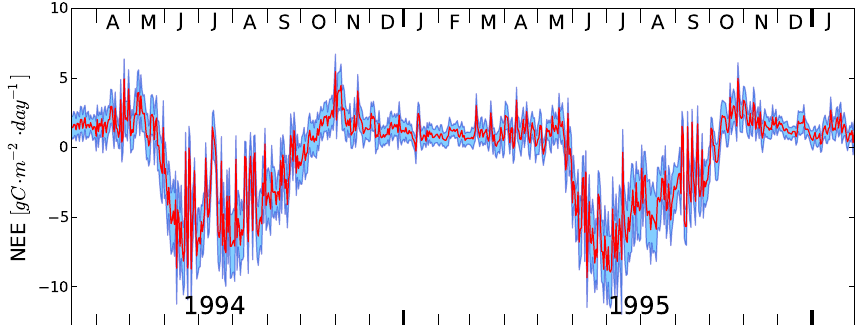
Figure 10. Snapshot of NEE observations (with red line) for the Harvard Forest site. The light-blue region, bordered by thick blue lines corresponds to ± 2 σ around the daily NEE